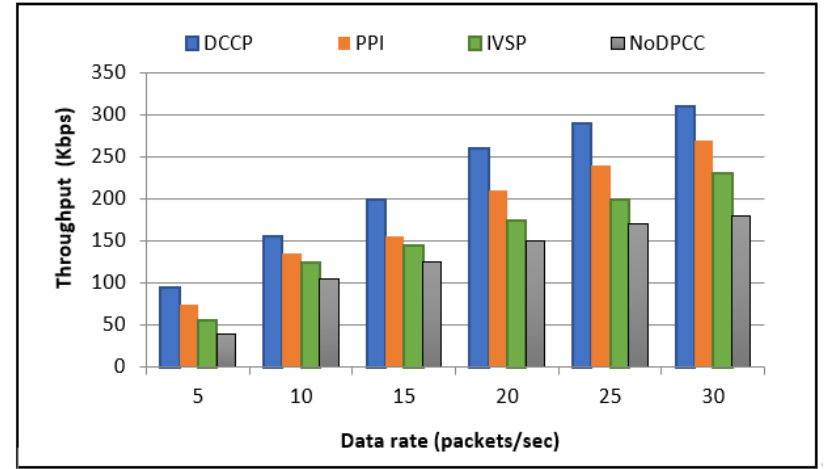
Figure 16. Throughput vs. data rate.